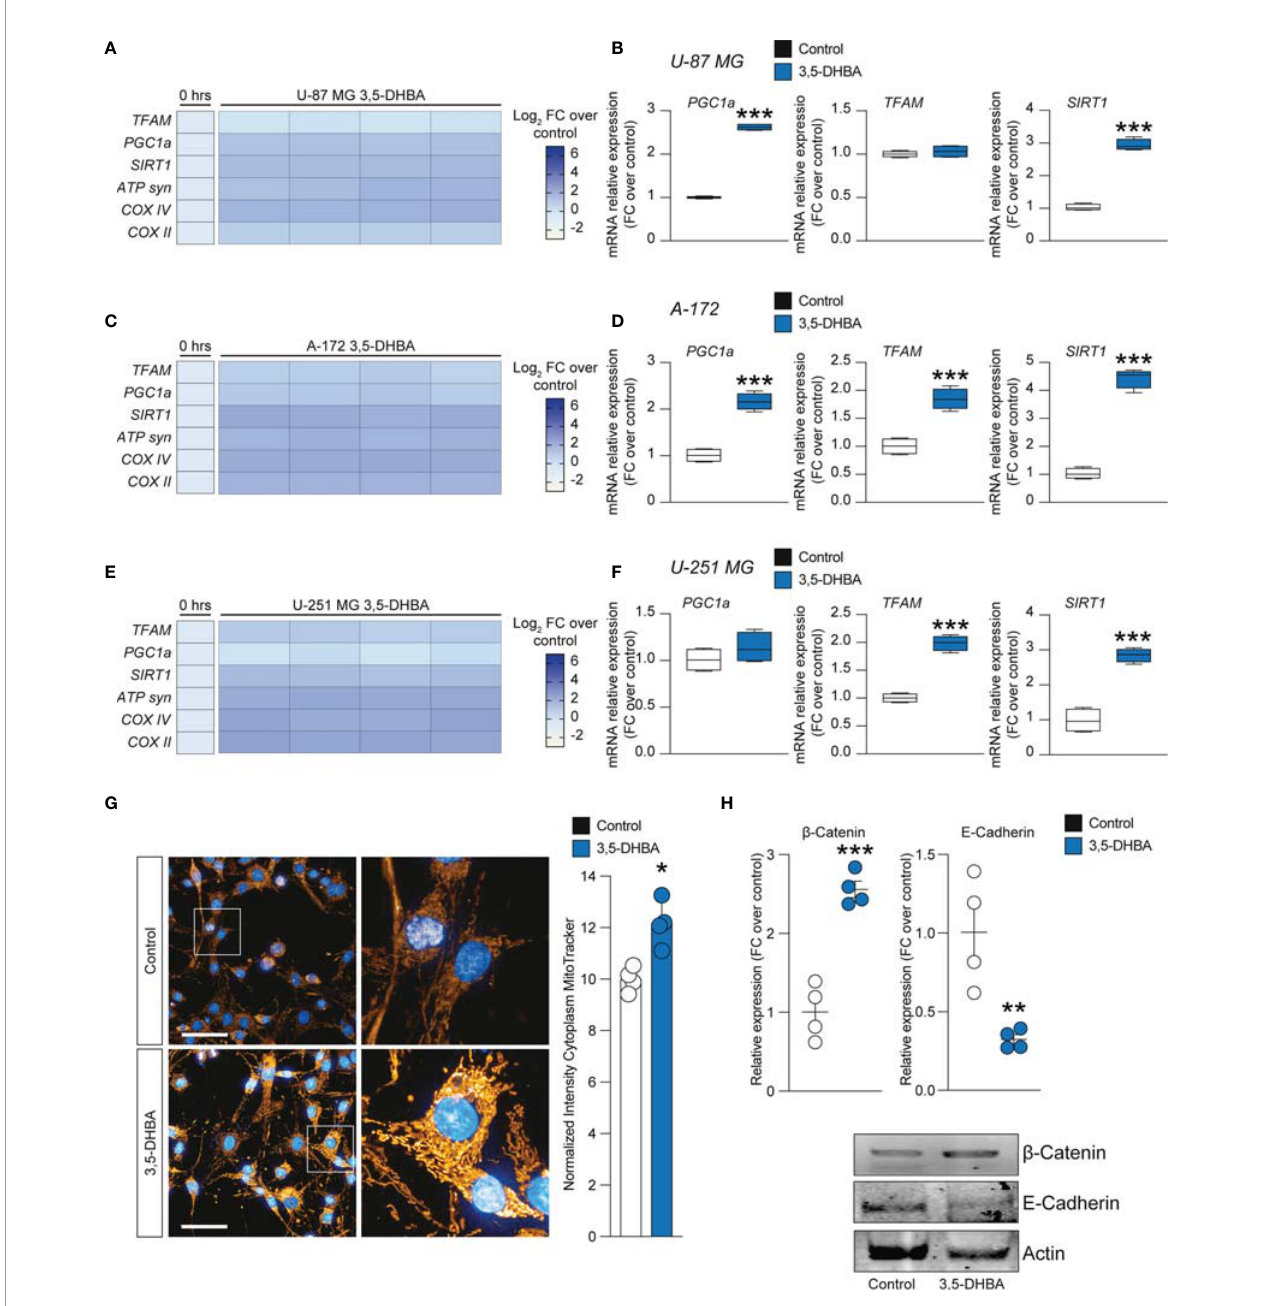
FIGURE 5 | HCAR1 selective stimulation promoted the upregulation of mitochondrial activity gene expressions and regulated the protein expressions of the epithelial – mesenchymal transition (EMT) markers in glioblastoma cells. (A – F) Effect of 3,5-dihydroxybenzoic acid (3,5-DHBA, 150 m M) on mitochondrial biogenesis and OXPHOS gene expression in U-87 MG cells (A, B) , A-172 cells (C, D) , and U-251 MG cells (E, F) following 24 h of treatment. (G) Computerized analysis of the MitoTracker fl uorescence intensity on the control versus lactate 18 h after treatment. The fi gures presented are representative of at least three independent experiments. (H) Protein expressions of b -catenin and E-cadherin in A-172 cells following 72 h of HCAR1 stimulation. The fi gures presented are representative of at least four independent experiments, and values represent the mean ± SEM of experiments performed in quadruplicate. P -values <0.05 were considered as statistically signi fi cant (* p < 0.05; ** p < 0.01; *** p < 0.001 vs .